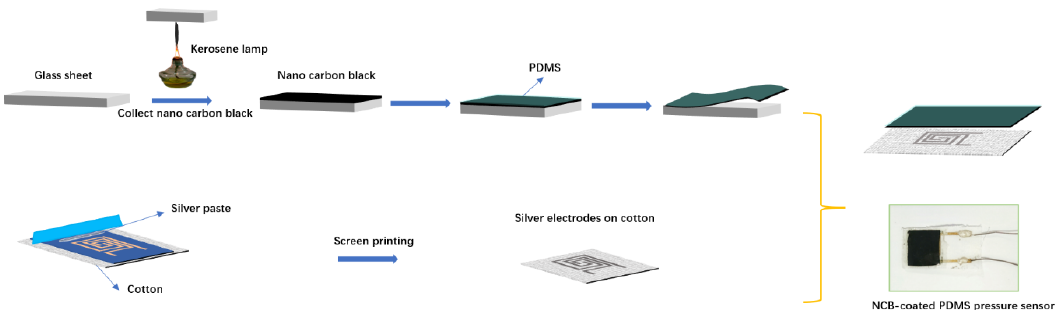
Figure 1. Schematic illustration of the fabrication process and device structure of the nano carbon black (NCB)-coated piezoresistive-based sensor and its digital photograph.